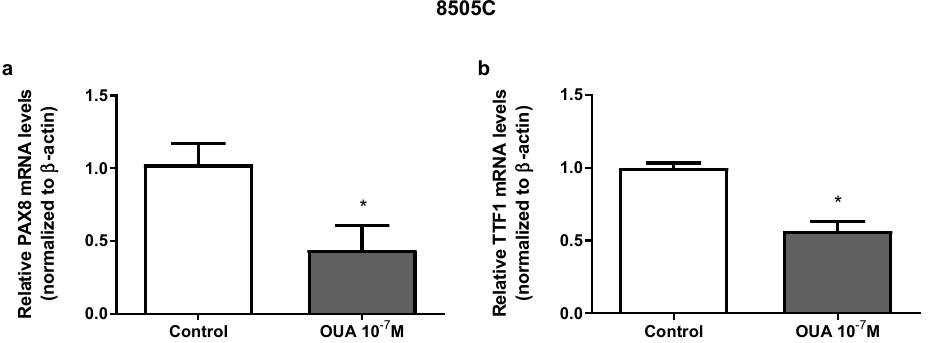
Figure 5. Effect of ouabain on mRNA expression of PAX8 and TTF1 in 8505C cells. Following 24 h of 8505C culture in the absence or presence of ouabain 10 − 7 M, PAX8 and TTF1 mRNA levels were evaluated by RT-PCR. ( a , b ) Data are presented as the mean ± SEM of mRNA levels of PAX8 ( a ) and TTF1 ( b ) of at least three independent experiments, each performed in triplicate. * p < 0.05 using unpaired t -test.